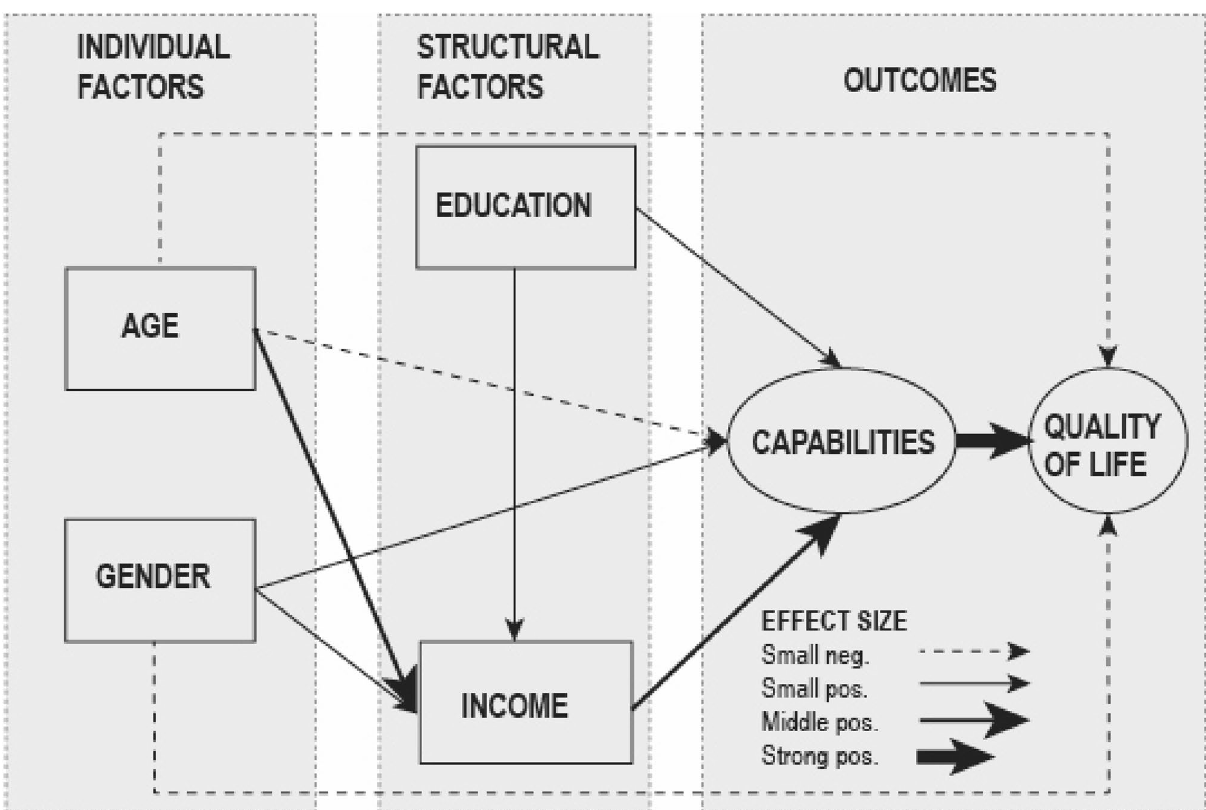
Figure 4. A simplified presentation of the effects of individual and structural factors and capabilities on different dimensions of QoL in the examined groups. SEM-modelling with latent variables, PROMEQ data (N =